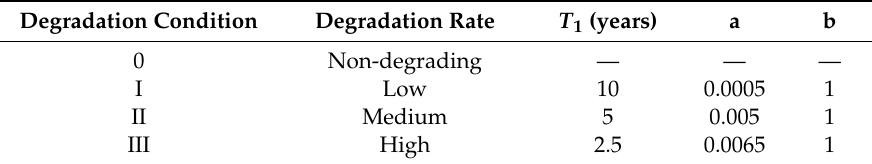
Table 4. Typical parameters governing di ff erent steel degradation rates (Equation (10)).